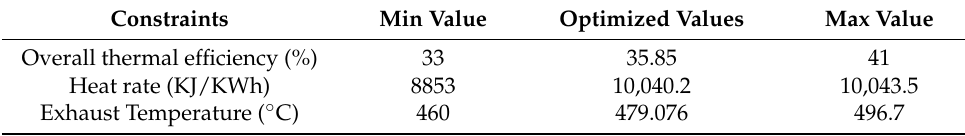
Table 1. Input data for design point model .